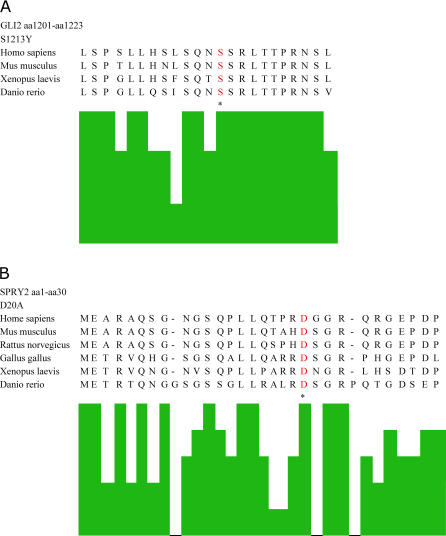
Protein Comparisons of the Available Gene Orthologs for GLI2 S1213Y and SPRY2 D20AGLI2 S1213Y (A) and SPRY2 D20A (B): Green bars indicate degree of conservation in each site. Amino acids in red indicate the mutation sites. All mutation comparisons are available as supplemental material at http://genetics.uiowa.edu/publications.html.